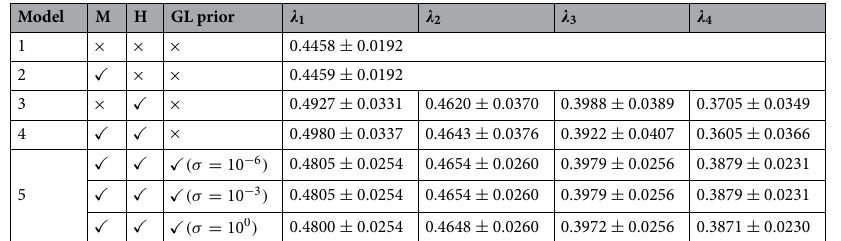
Table 3. Estimated (cid:31) i with standard deviation using Models 1–5 for simulated data with four provinces. Recall that the ground truth is (cid:31) 1 = 0.5 , (cid:31) 2 = 0.47 , (cid:31) 3 = 0.4 , (cid:31) 4 = 0.37 . Models in Column 1 are detailed in Table 2. Columns 2–4 indicate whether the model permits migration between provinces (for “M”), the heterogeneity of parameters (for “H”) and the Graph Laplacian prior (for “GL prior”), respectively. (cid:31) i are inferred for each of the 100 replicas, and then the mean and standard deviation are presented in the table above. In addition, for parameter inference using Model 5 µ = 10 2.7 , ( σ = 10 − 6 , 10 − 3 , 10 0 respectively), at which the averaged relative validation errors over 100 replicas are minimized as shown in Supplementary Figs. S2 and S3.